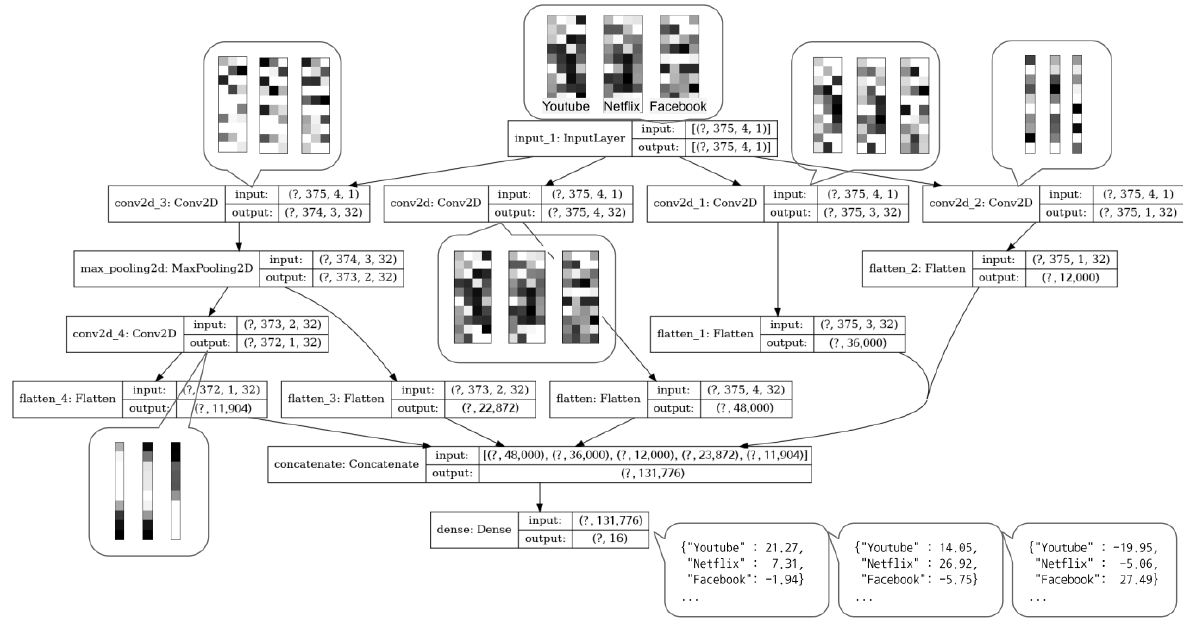
Figure 4. Convolution neural network model for classification of Internet traffic